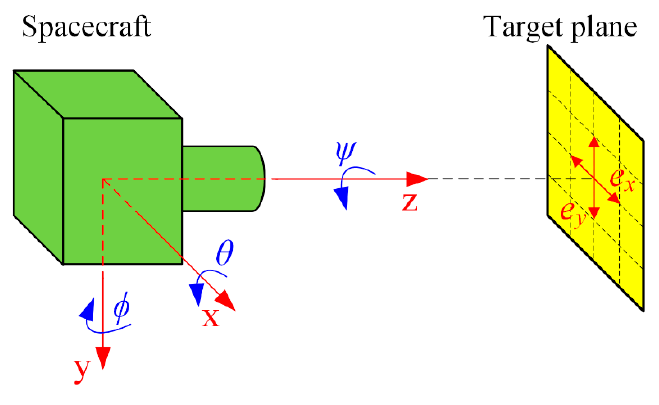
Figure 1. Schematic diagram of pointing error.